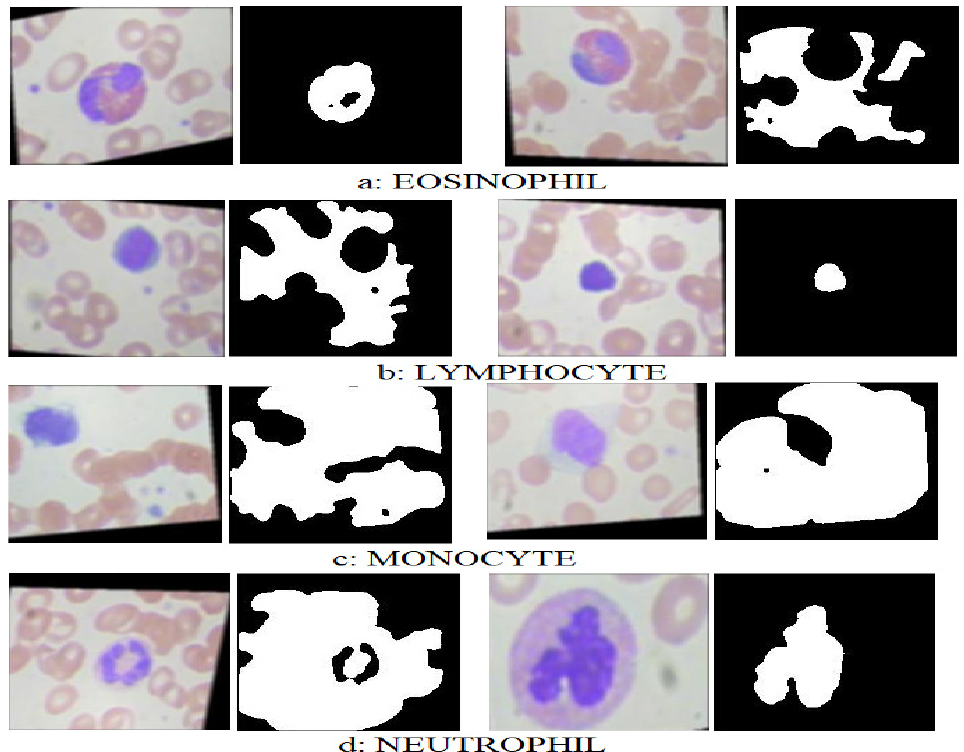
Figure 4. Samples of the dataset after segmentation.